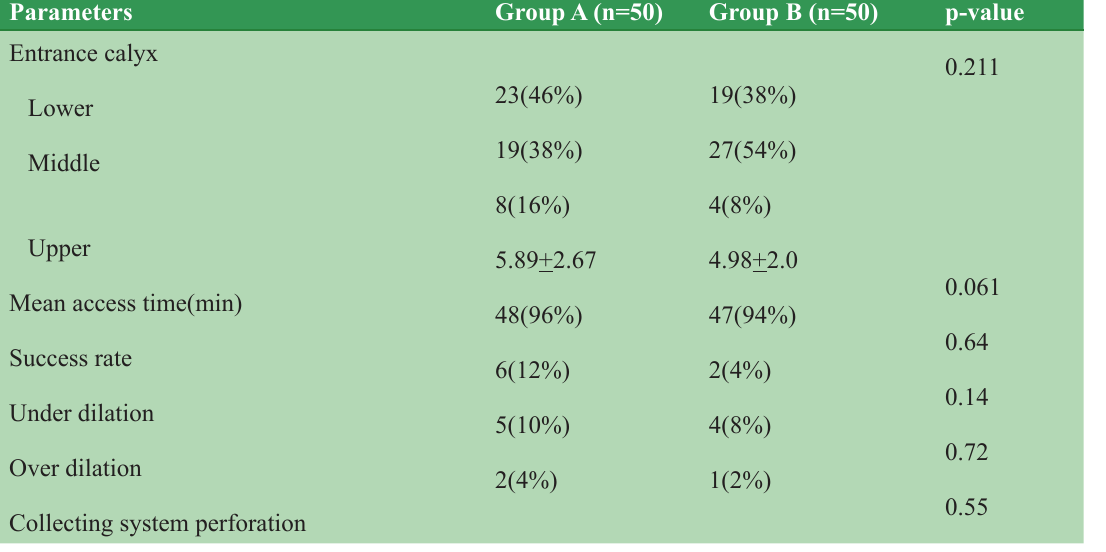
Table 2. Intraoperative